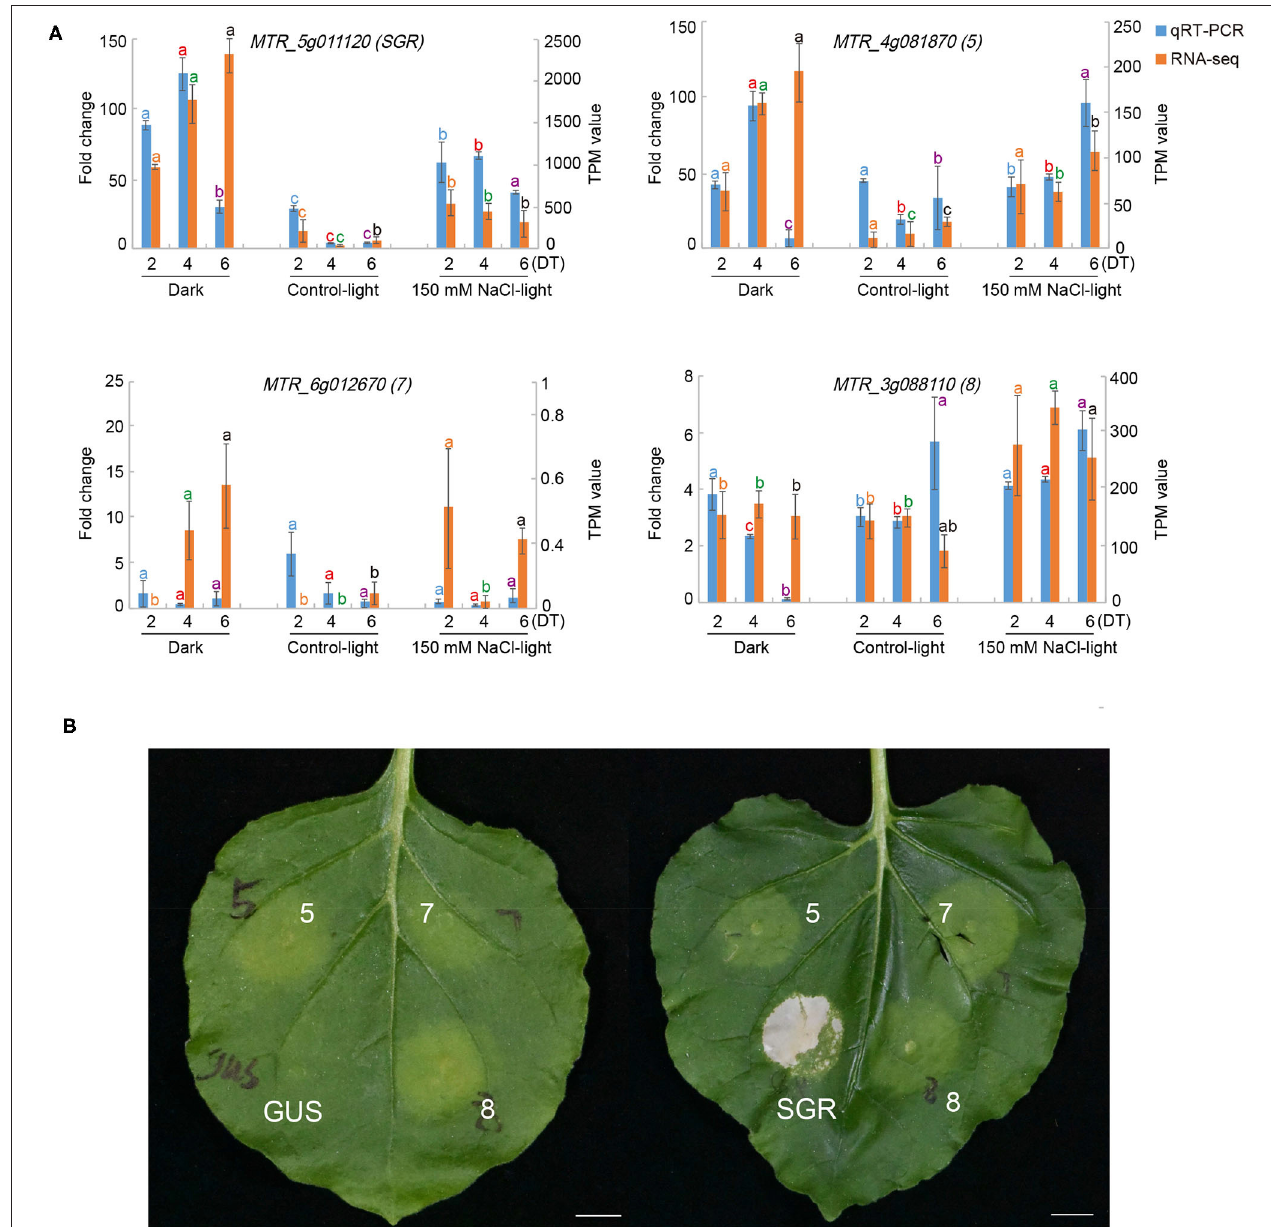
FIGURE 8 | Functional validation of selected senescence-associated genes (SAGs) using an Agrobacterium -mediated transient expression assay. (A) The relative expression fold change of selected SAGs under dark (Dark), normal light (Control-light), and 150mM NaCl (150mM NaCl-light) conditions on day 2, 4, and 6 compared with day 0 by RNA-seq and qRT-PCR. (B) Representative Nicotiana benthamiana leaf senescence symptoms 24h after infiltration with different constructs encoding MTR_5g011120 ( SGR ), MTR_4g081870 (5), MTR_6g012670 (7), MTR_3g088110 (8), and empty vector with GUS,